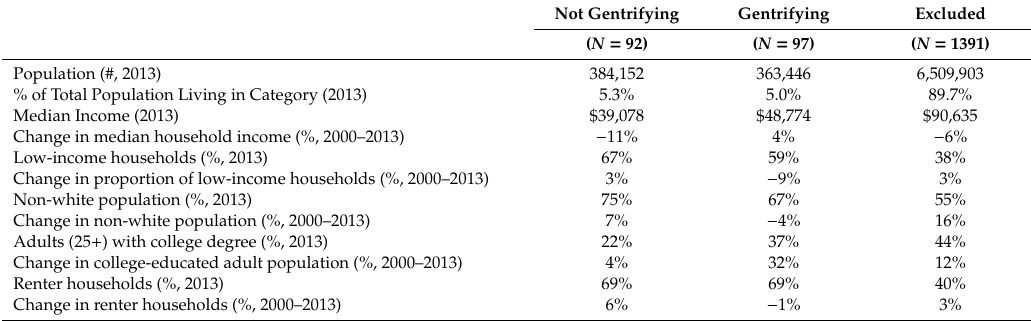
Table 1. The demographics of Freeman Gentrification Typologies, the San Francisco Bay Area